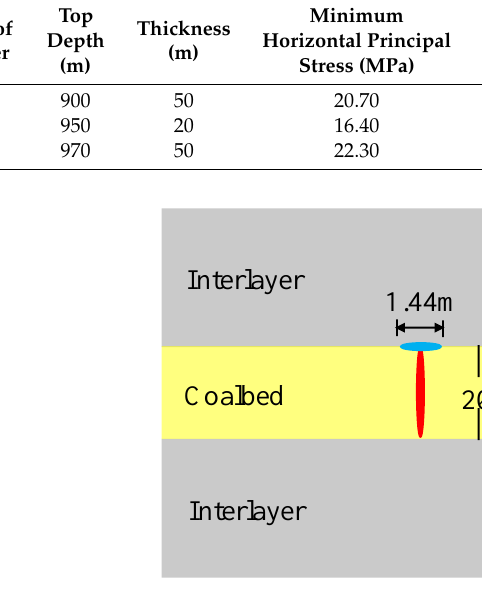
Figure 6. Vertical fracture morphology with injection pressure value of 17.30 MPa at perforation.